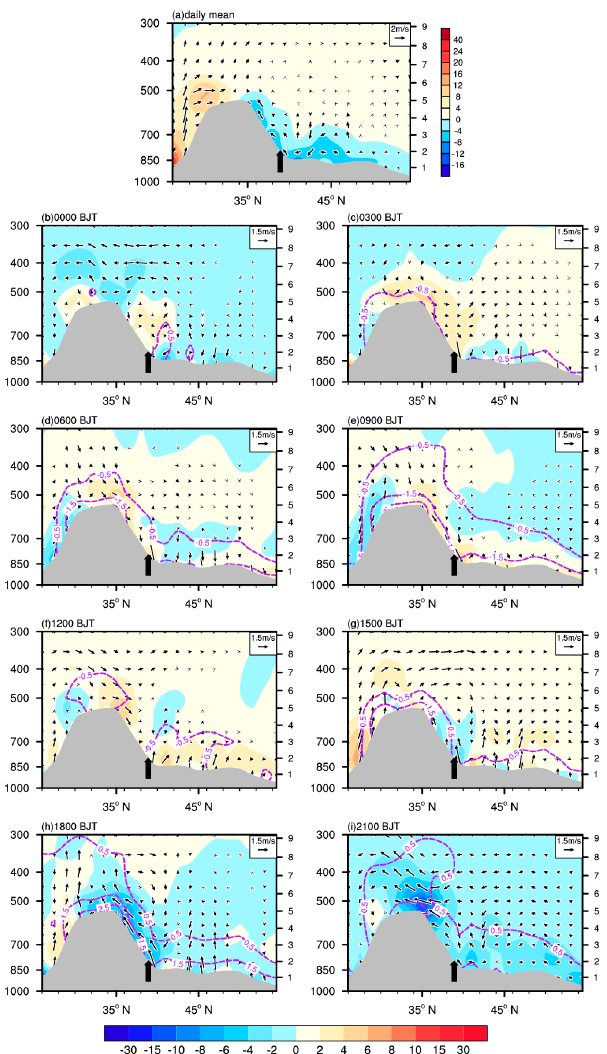
Figure 7. ( a − i ) are the same as in Figure 5a − i, but for the meridional water vapor transport and Figure 7. ( a – i ) are the same as in Figure 5a–i, but for the meridional water vapor transport and vertical circulation along 79° − 99° E. The omega has been multiplied by − 20 (unit: Pa s − 1 ). The black vertical circulation along 79 ◦ –99 ◦ E. The omega has been multiplied by − 20 (unit: Pa s − 1 ). The black upward arrows above the topography indicate the northern boundary of the TP. upward arrows above the topography indicate the northern boundary of the